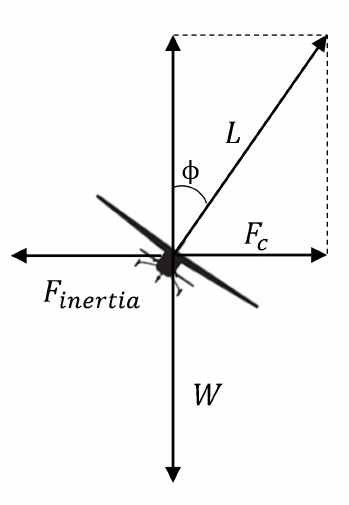
Figure 9: Diagram of the forces acting on the airplane during each